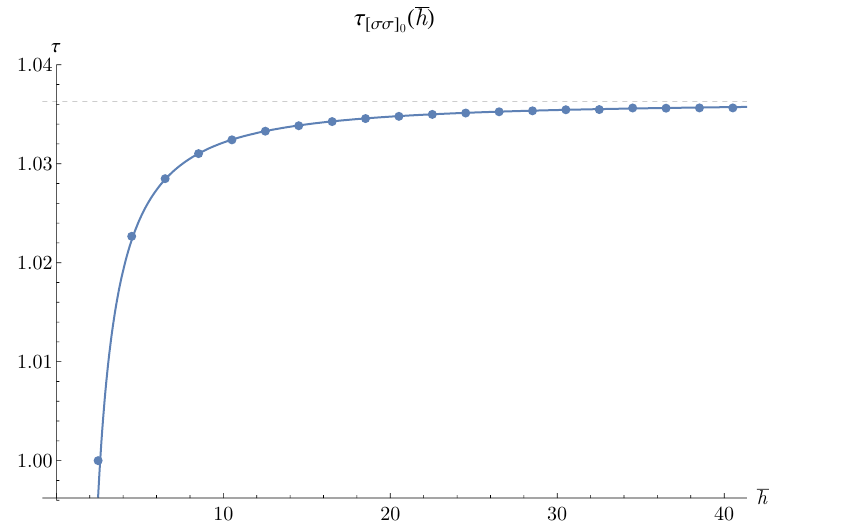
Figure 1. Twists of the double-twist family [ (cid:27)(cid:27) ] 0 . Here, we plot (cid:28) = (cid:1) (cid:0) ‘ versus h = (cid:1)+ ‘ The dots show estimates from [10] using the extremal functional method [7, 35, 36] and the nu- merical bootstrap. The curve shows the prediction of large-spin perturbation theory with only (cid:1) (cid:27) ; (cid:1) (cid:15) ; f (cid:27)(cid:27)(cid:15) ; c T taken from the numerical bootstrap. (cid:12)gure reproduced from [10].